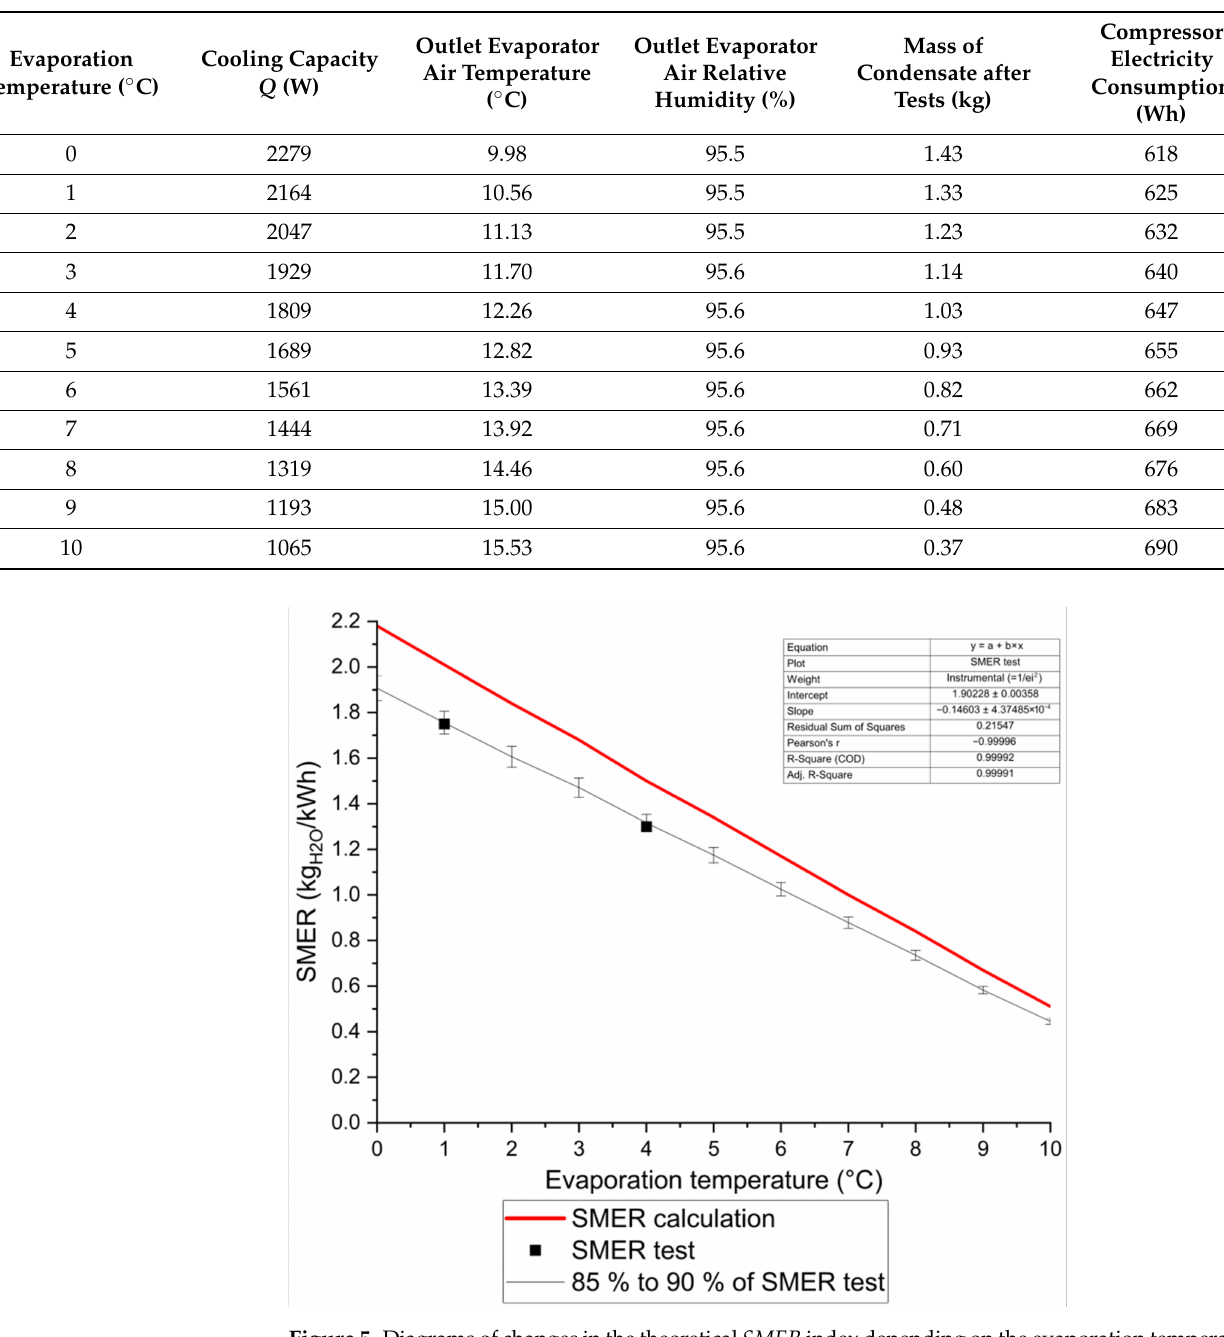
while maintaining the coefficient of determination, R-squared, at the level of 0.99991 and with the measurement uncertainty of 2.8% obtained for the tested operating